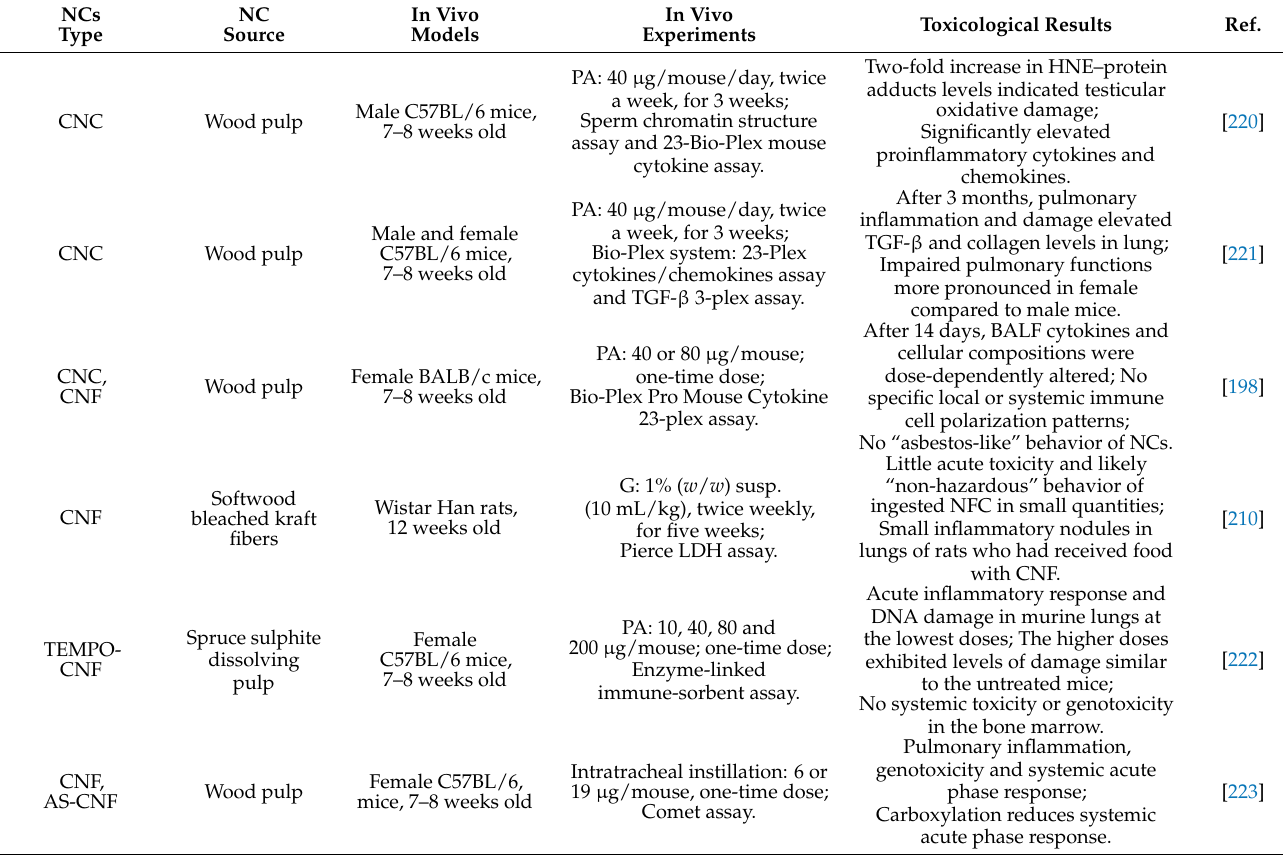
Table 7. Cytotoxicity evaluations in in vivo studies induced by NCs- and NCs-based